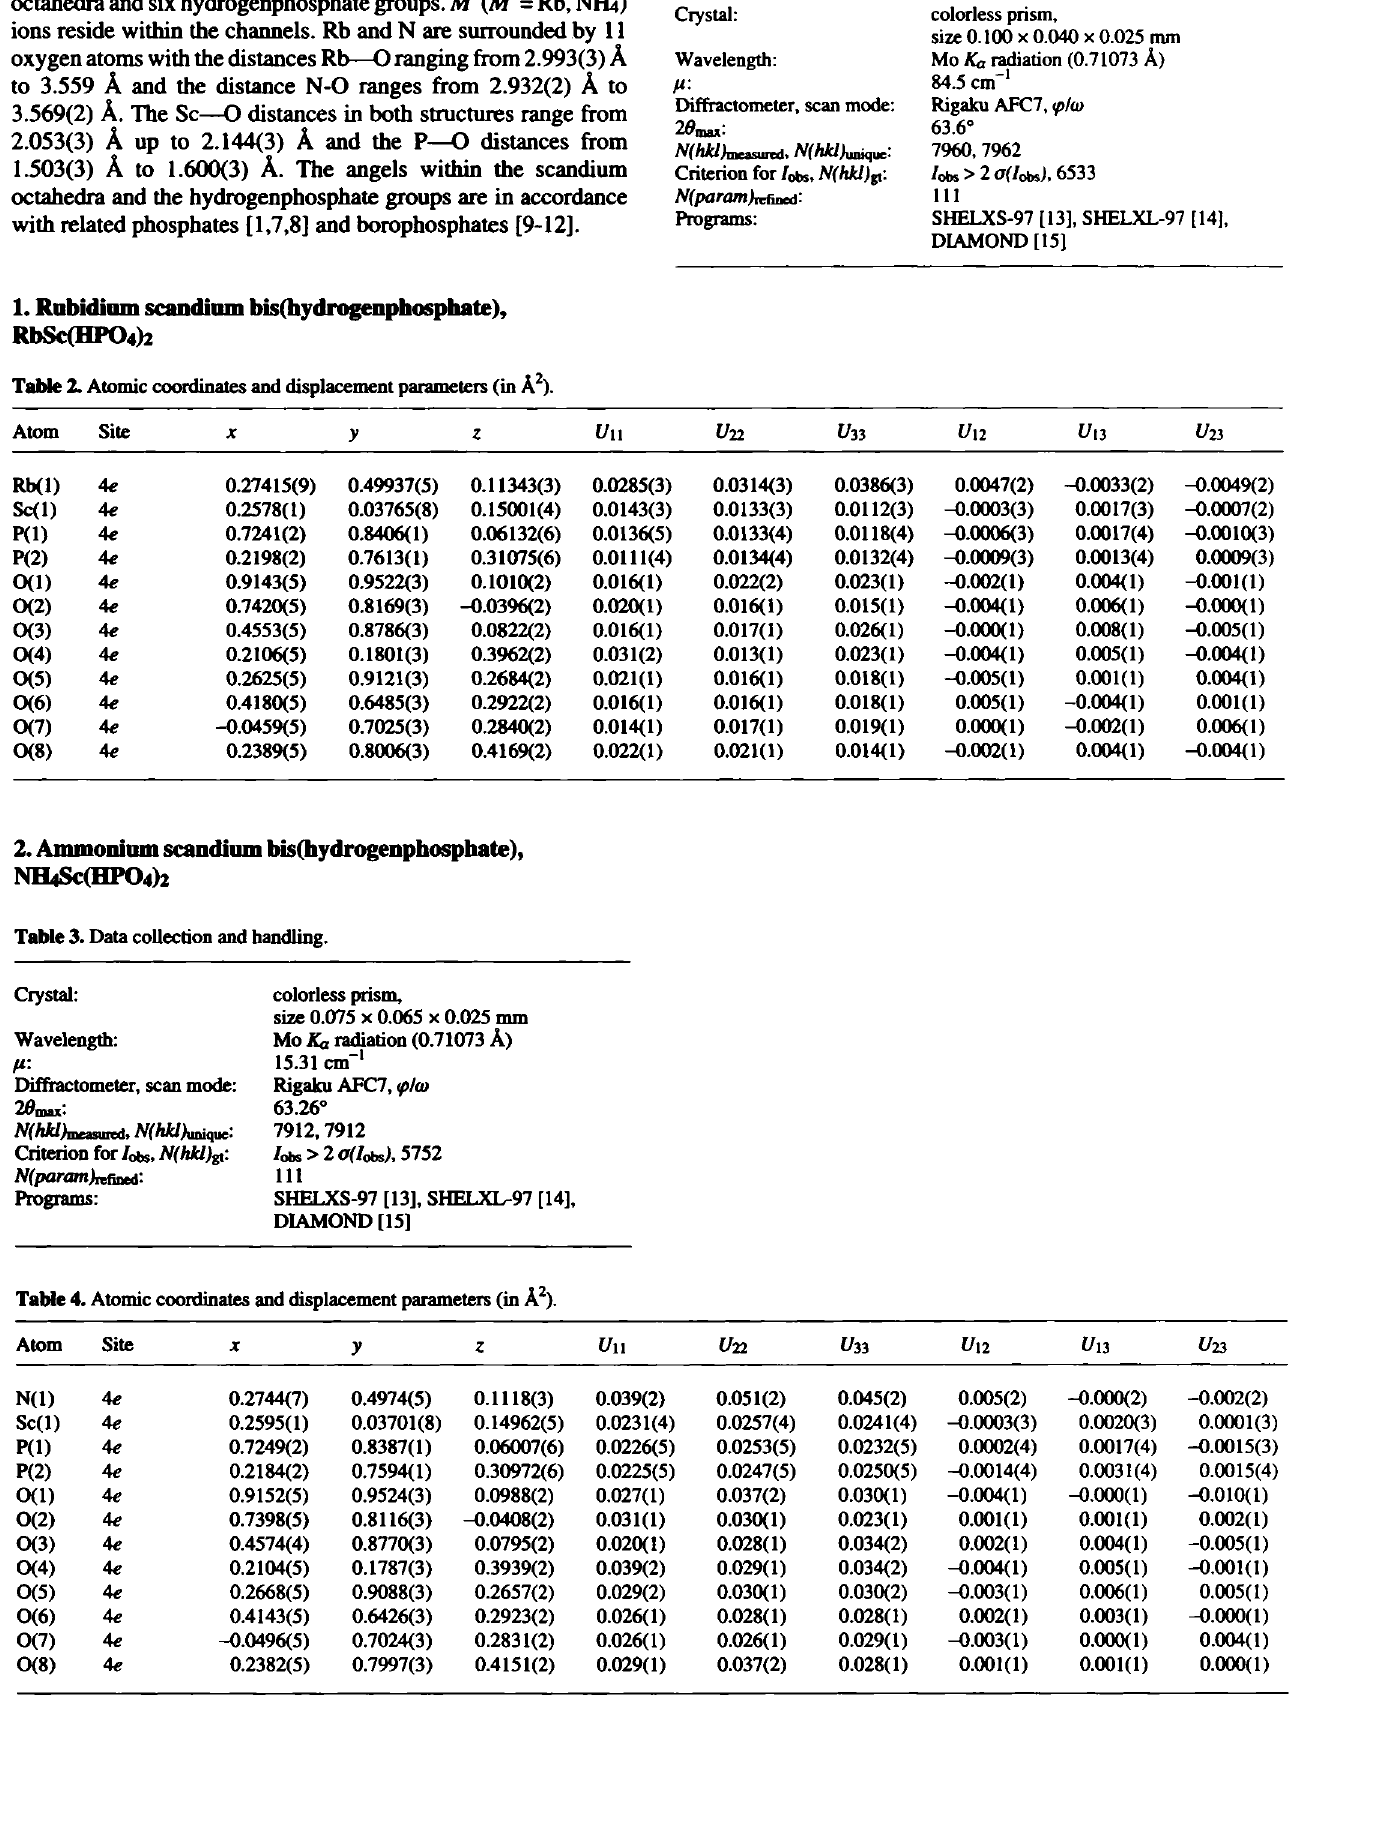
Table 2. Atomic coordinates and displacement parameters (in A 2 ).